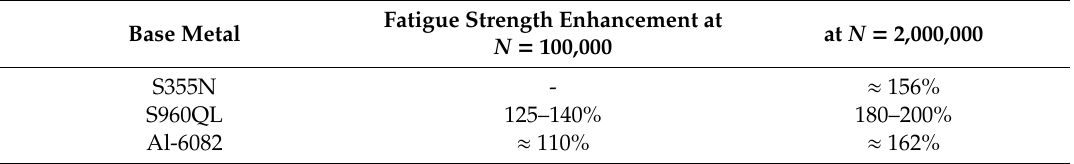
Table 6. Fatigue strength enhancement of the S-N curve in dependence of the base metal after shot